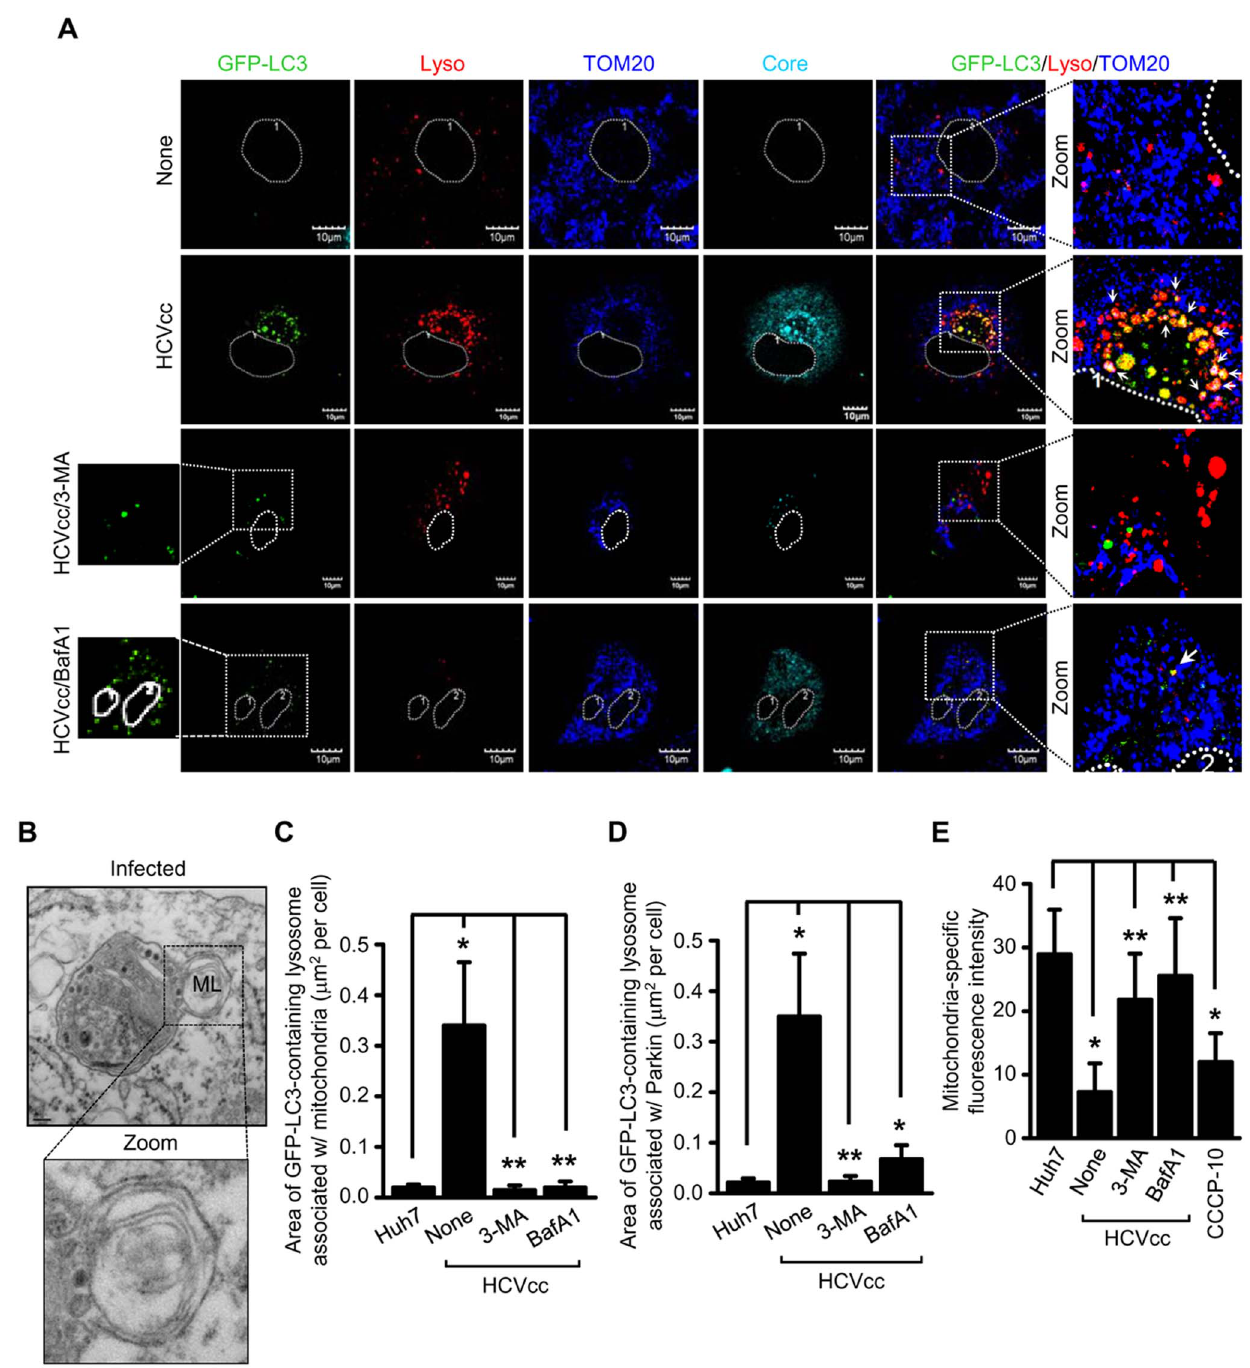
Figure 5. HCV induces complete mitophagolysosome formation. Confocal microscopy showing the formation of mitophagolysosome in HCV-infected cells. ( A ) Huh7 cells transiently expressing GFP-LC3 protein were infected with HCVcc in the absence or presence of 3-MA (10 mM) and BafA1 (100 nM), respectively, for 12 h before fixation. At 3 days post-infection, cells prestained with LysoTracker (red) were immunostained with antibodies against TOM20 (blue) and HCV core (cyan). Nuclei are demarcated with white dot circles. In the zoomed images, the arrows indicate the colocalization of GFP-LC3 puncta (green), lysosome, and mitochondria in HCV-infected cells (white puncta). ( B ) Ultrastructure of HCV-infected cells showing the formation of mitophagolysosome. HCV FLR-JFH1 replicon cells were examined by electron microscopy. In the zoomed image, the formation of mitophagolysosome in HCV-infected cells is shown. Organelle marker: ML, mitophagolysosome. Scale bar=0.1 m M. ( C and D ) Quantitative analyses of the colocalization of GFP-LC3 containing lysosomes with mitochondria ( C ) or Parkin ( D ) in the panels ( A ) and Figure S5 (mean 6 SEM; n $ 10 cells; * p , 0.001, ** p , 0.05). ( E ) ImageJ quantitative analysis of the number of mitochondria (mean 6 SEM; n $ 10 cells; * p , 0.001, ** p , 0.05). P values were calculated by using an unpaired Student’s t-test.